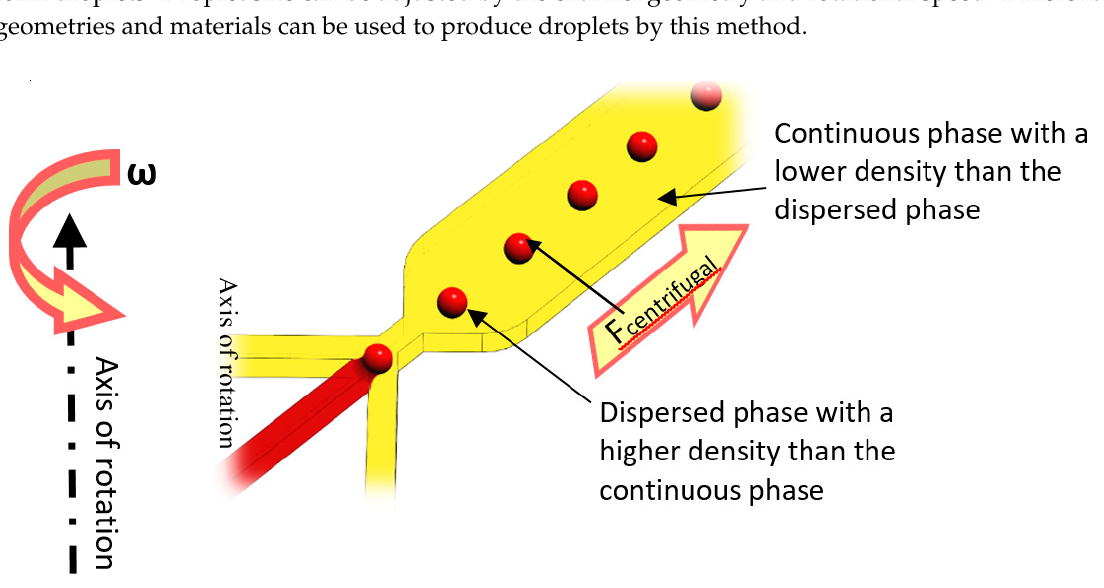
Figure 13. A schematic view of the crossflow mechanism of droplet generation on lab-on-a-disk (LOD) devices.